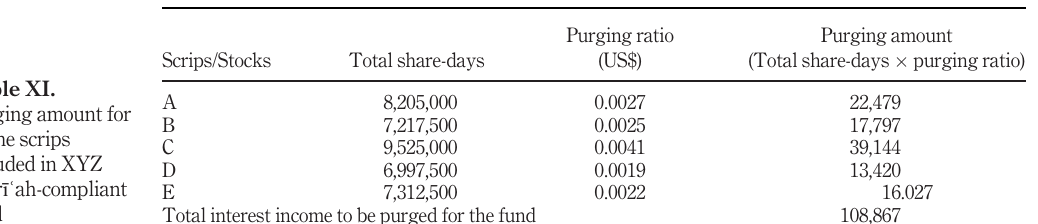
Table X. Share-days for all the scrips included in XYZ Shar ī ʿ ah- compliant fund